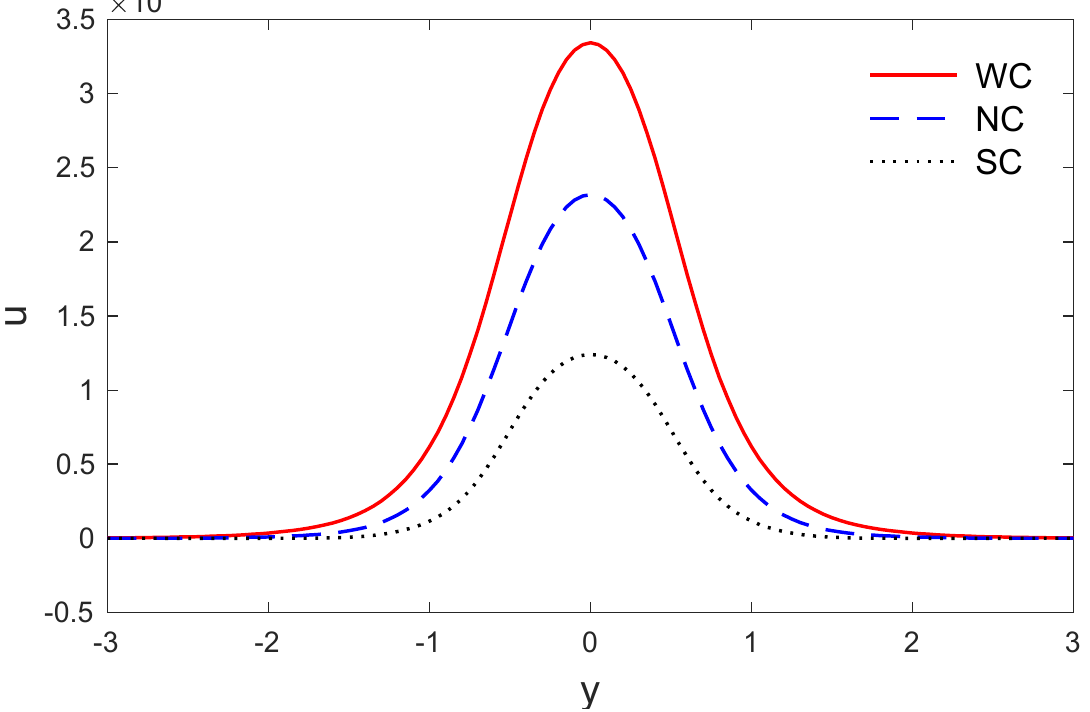
Figure 10. The variations of horizontal displacement u via y with x = 0.4 for strong normal and weak conductivities.